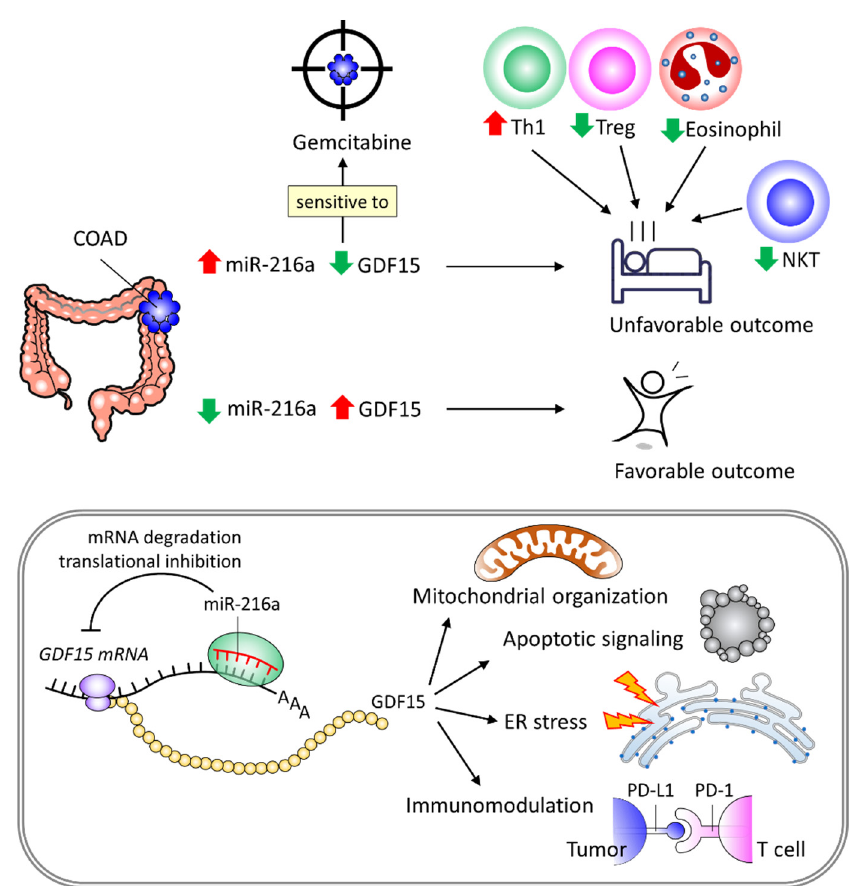
Figure 10. Proposed model depicting the significance of the miR-216a/ GDF15 axis in diagnosis, prognosis, tumor immunity, and precision treatment with Gemcitabine in COAD and its correlation for mitochondrial organization, apoptotic signaling, endoplasmic reticulum (ER) stress, and immunomodulation.